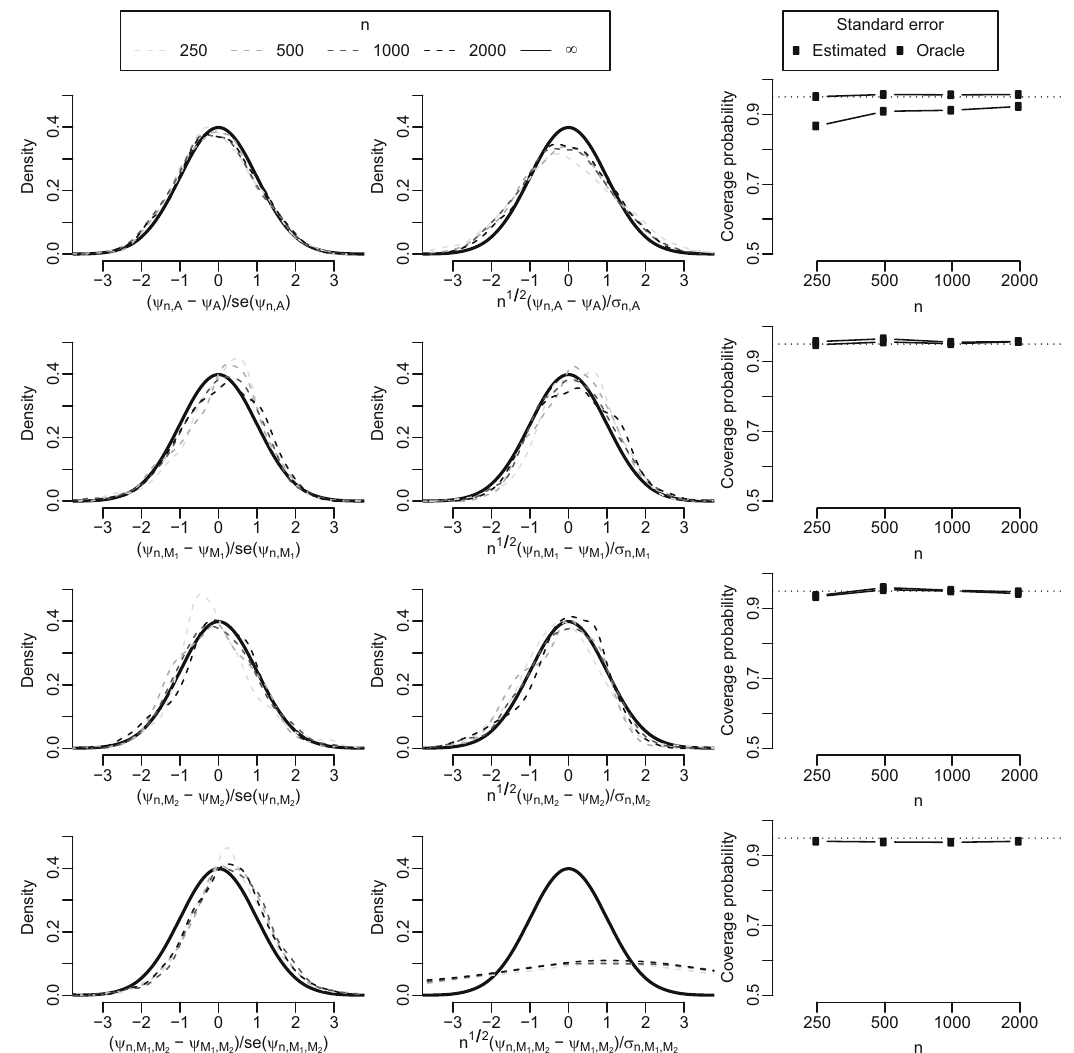
Figure 4: Illustration of weak convergence and Wald - style con fi dence intervals based on the TMLE. The left two columns show the kernel density estimate of the sampling distribution of the centered estimates of interventional e ff ects scaled by the oracle standard error ( left ) and by their estimated standard error ( middle ) . In each case, the asymptotic distribution is shown in black. The right panel shows coverage probability of a nominal 95% Wald - style con fi dence interval based on an oracle standard error ( solid circle ) and an estimated standard error ( open circle )